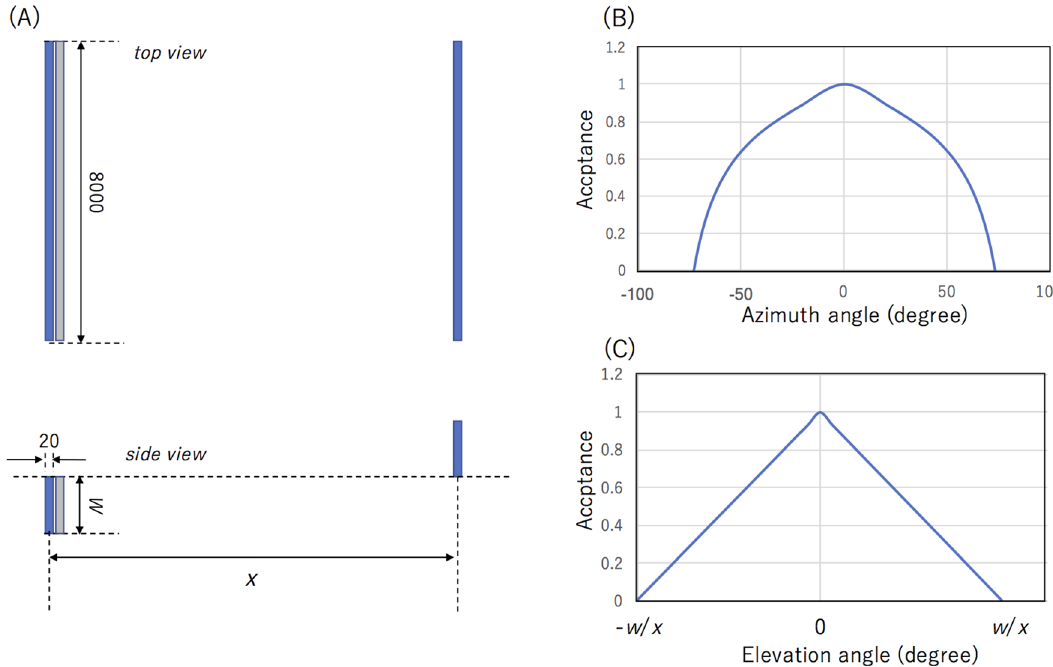
Figure 8. Geometric configuration of HKMSDD-MSM for the tide monitoring network. The top and side views of the setup are respectively shown in the top and bottom panel of ( A ) in units of mm. x indicates the distance between the two scintillator strips. The muons arriving from the right to the left side are detected with this configuration. It is expected that the muons arriving from another direction will be sufficiently suppressed (e.g., by a factor of 50 for w = 15 cm and x = 450 cm) (See Fig. 8). A gray rectangle indicates the 2-cm thick lead plate. The azimuthal ( B ) and elevation angle ( C ) acceptances are also shown for x > > w .